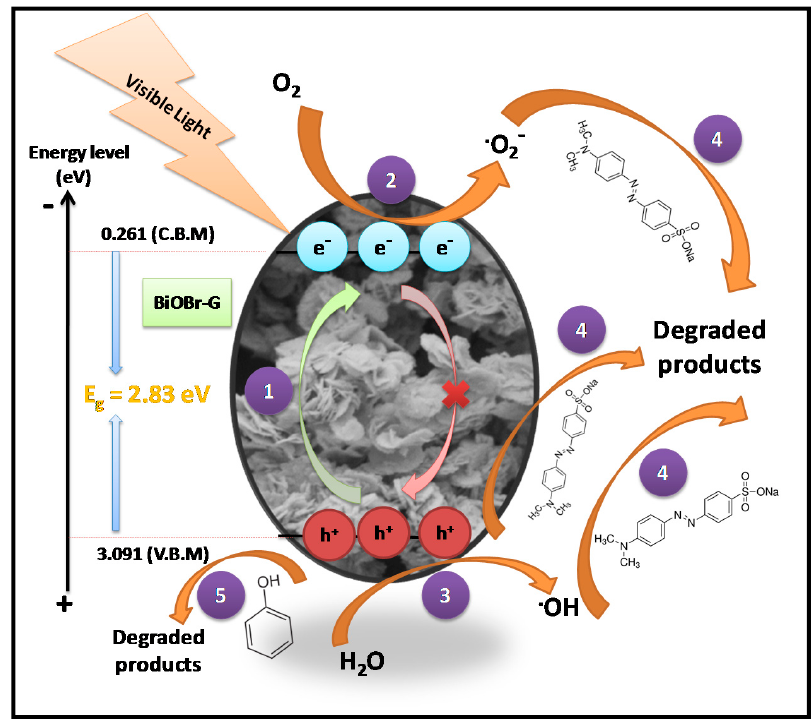
Figure 10. Photocatalytic degradation mechanism of MO and Ph.